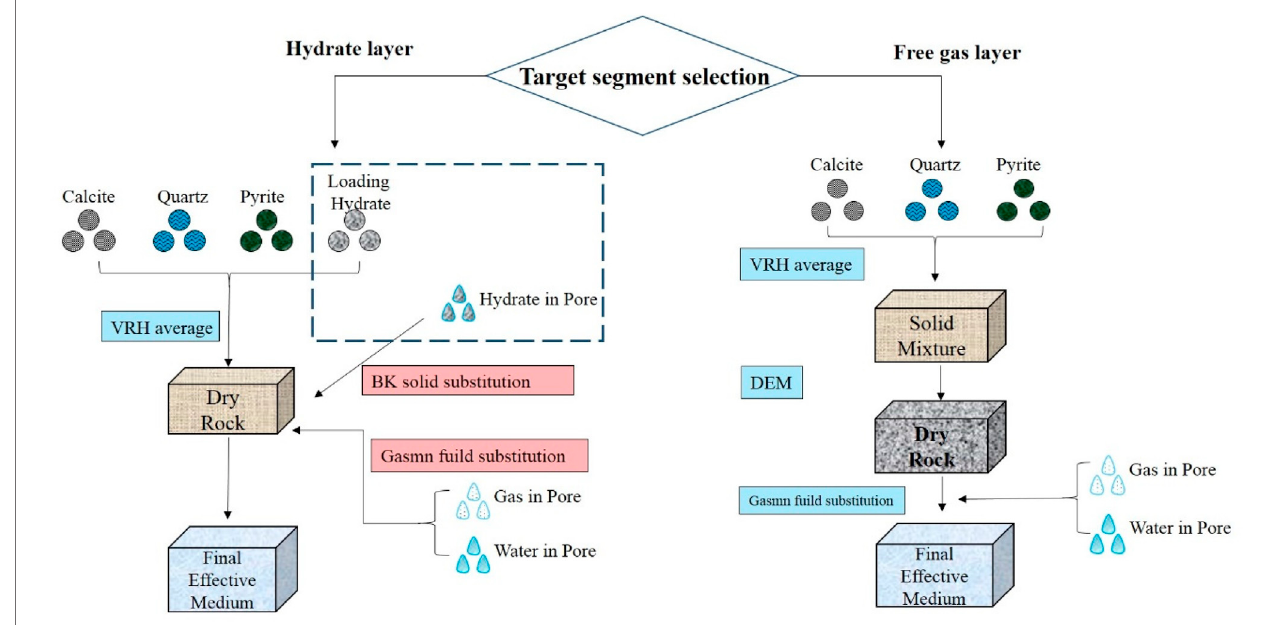
FIGURE 13 | Segmental petrophysical modeling process of hydrate and free gas layers.